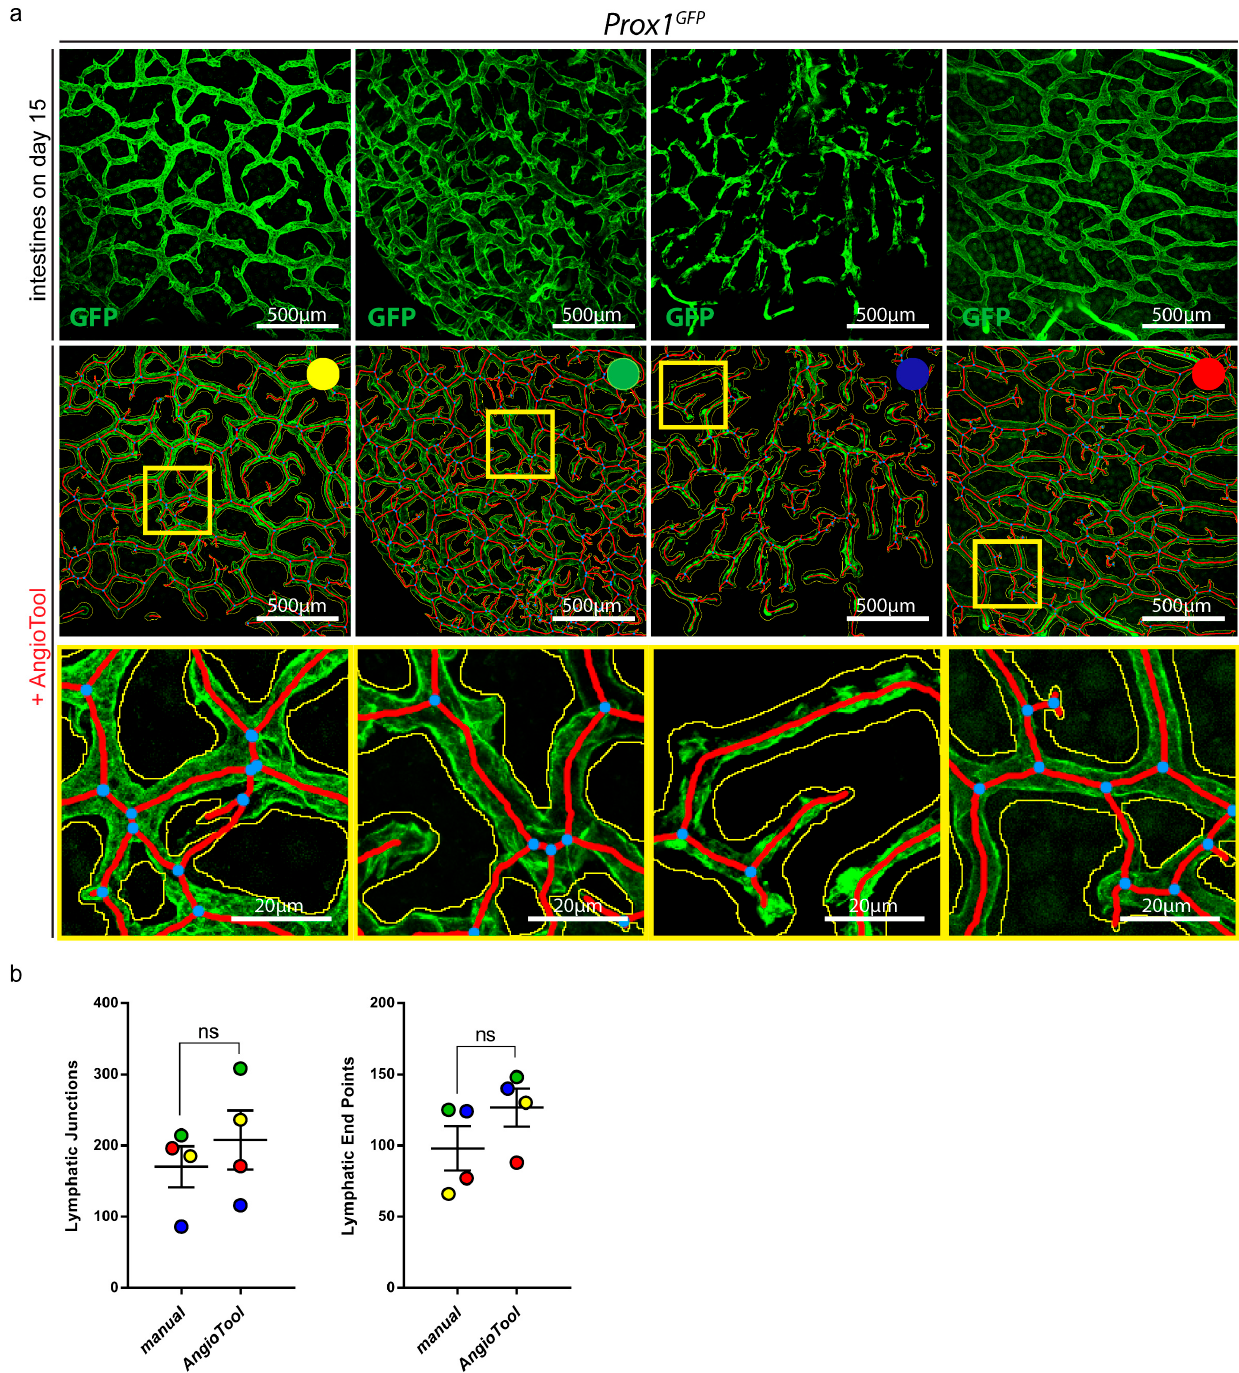
Figure 6. Quantification of organ-specific lymphatic vasculature. ( a ) Lymphatic vasculature of the small intestines of four Prox1 GFP mice on day 15 after the tissue-clearing protocol. Samples were stained with an anti-GFP antibody. Images were acquired by confocal microscopy, scale bar 500 μ m. Images were quantified with AngioTool, a user-friendly tool for the quantification of vasculature [29]. Every sample is marked with a specific color to analyze the results of the individual samples. Magnification of the images shows the quantification of AngioTool in detail: blue dots represent lymphatic junctions and red lines mark the length and the end points of lymphatic vessels. The